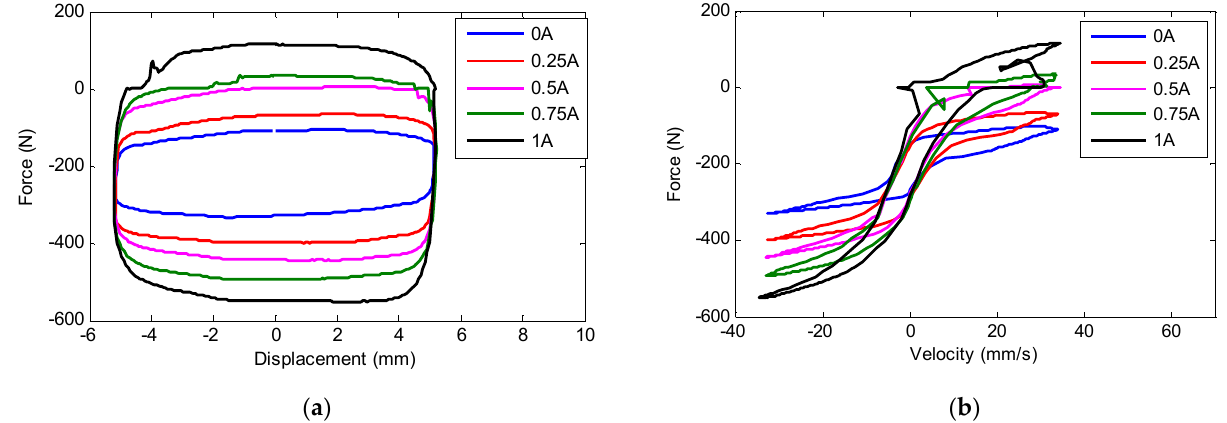
Figure 4. Damping characteristic diagram of the MRF damper ( a ): the displacement–force characteristic curves for different control currents under the harmonic excitation of 5 mm amplitude and 1 Hz frequency; ( b ) the velocity − force characteristic curves for different control currents under the harmonic excitation of 5 mm amplitude and 1 Hz frequency.